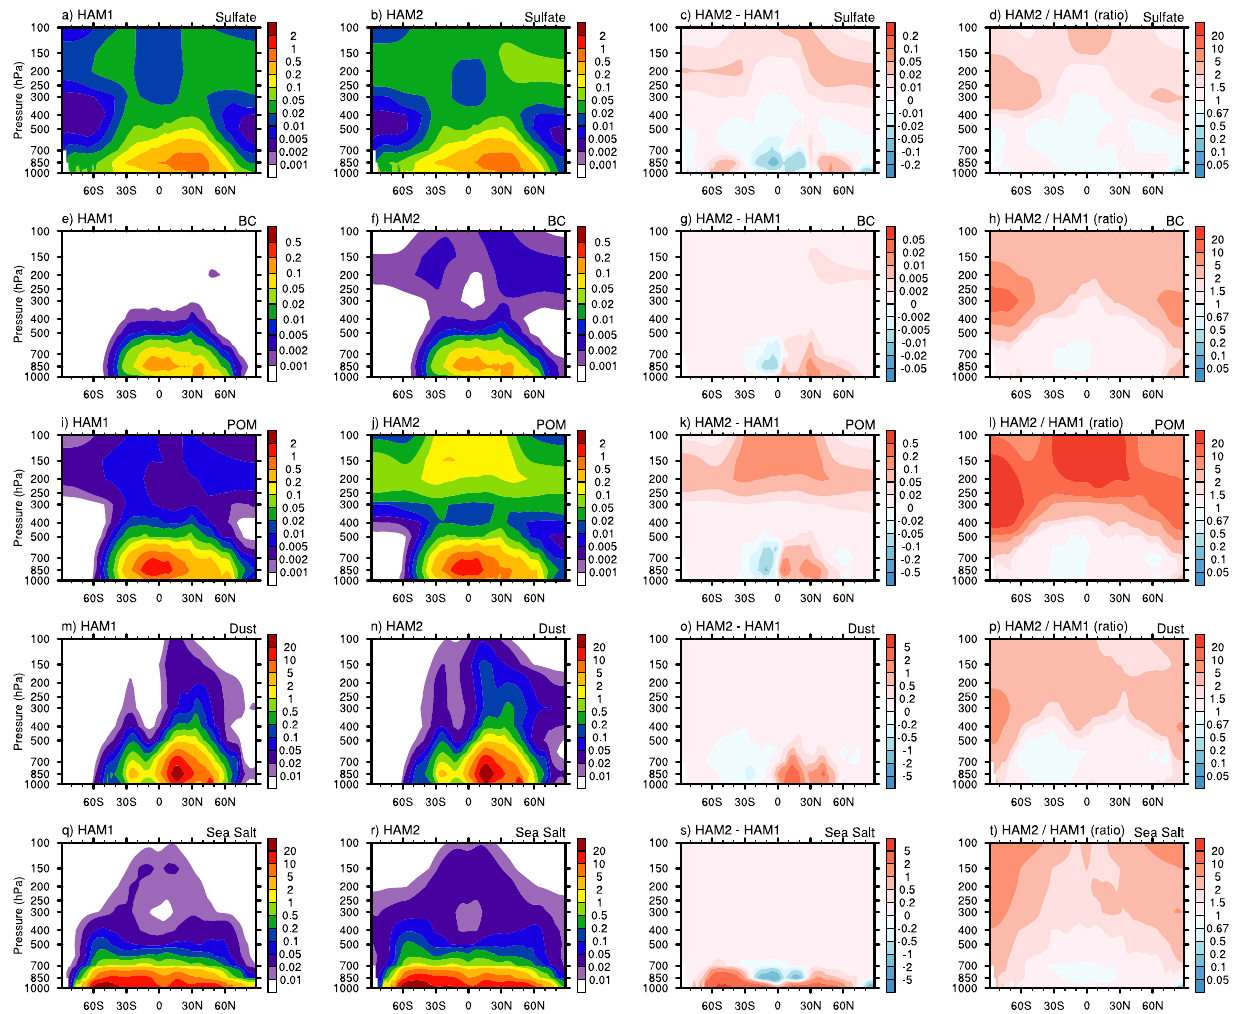
Fig. 9. Annual and zonal mean cross-sections of aerosol mass concentrations simulated by HAM1 (left column, unit: µg m − 3 ) and HAM2 (column 2, unit: µg m − 3 ), their differences (column 3, unit: µg m − 3 ), and the ratio (right